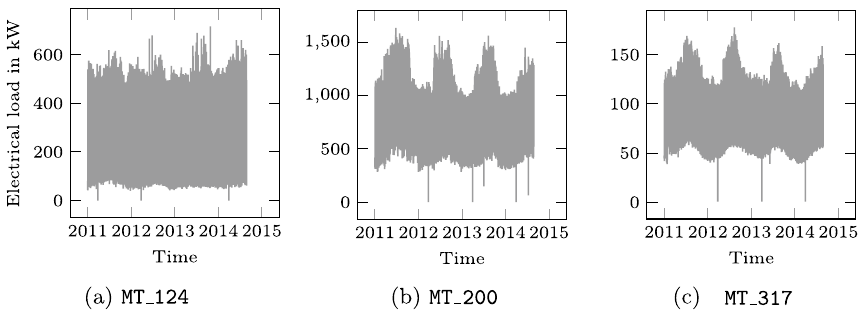
Fig. 2 The time series of the three clients from the UCI Electricity Load Dataset are used as target data in the